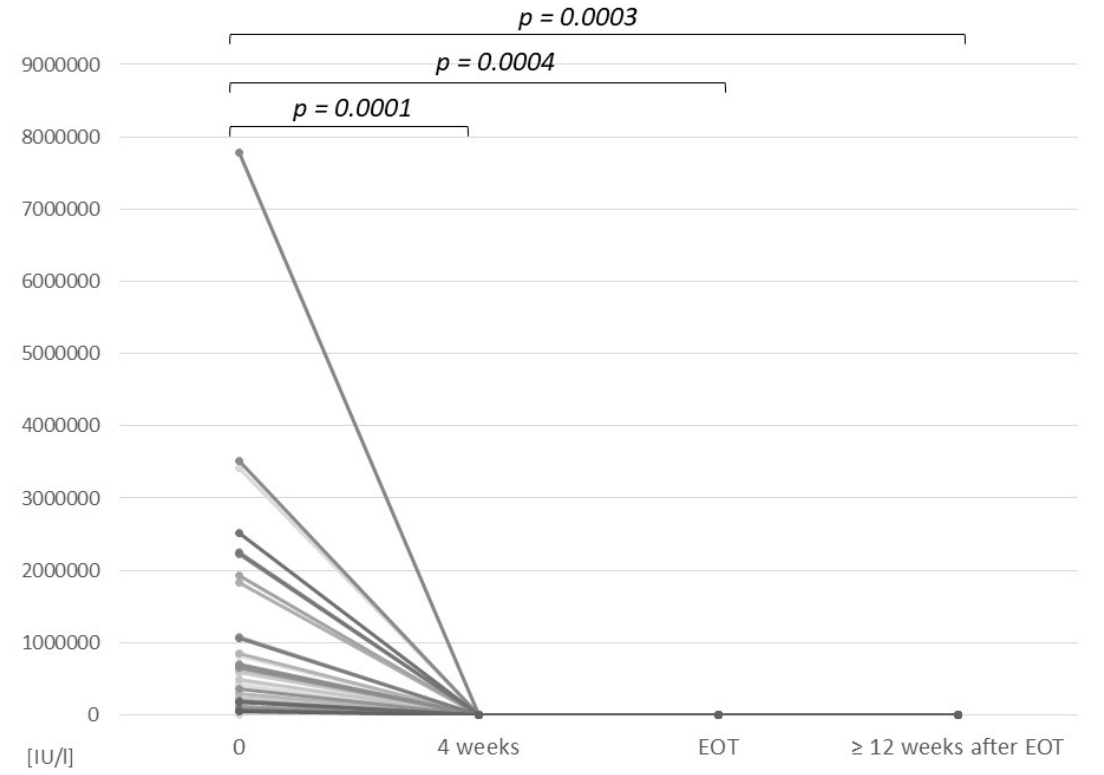
Figure 1. HCV viral load in 37 patients treated with LDV/SOF at baseline, at 4 weeks of treatment, at the end of treatment, and ≥ posttreatment week 12. EOT—end of treatment. Data at EOT were available for 31 patients.